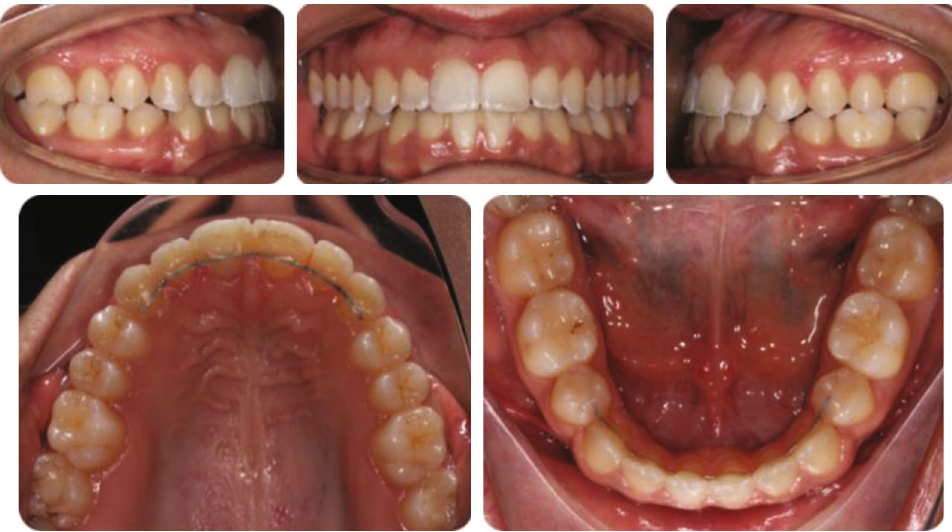
Figure 11: 12-month follow-up, intraoral